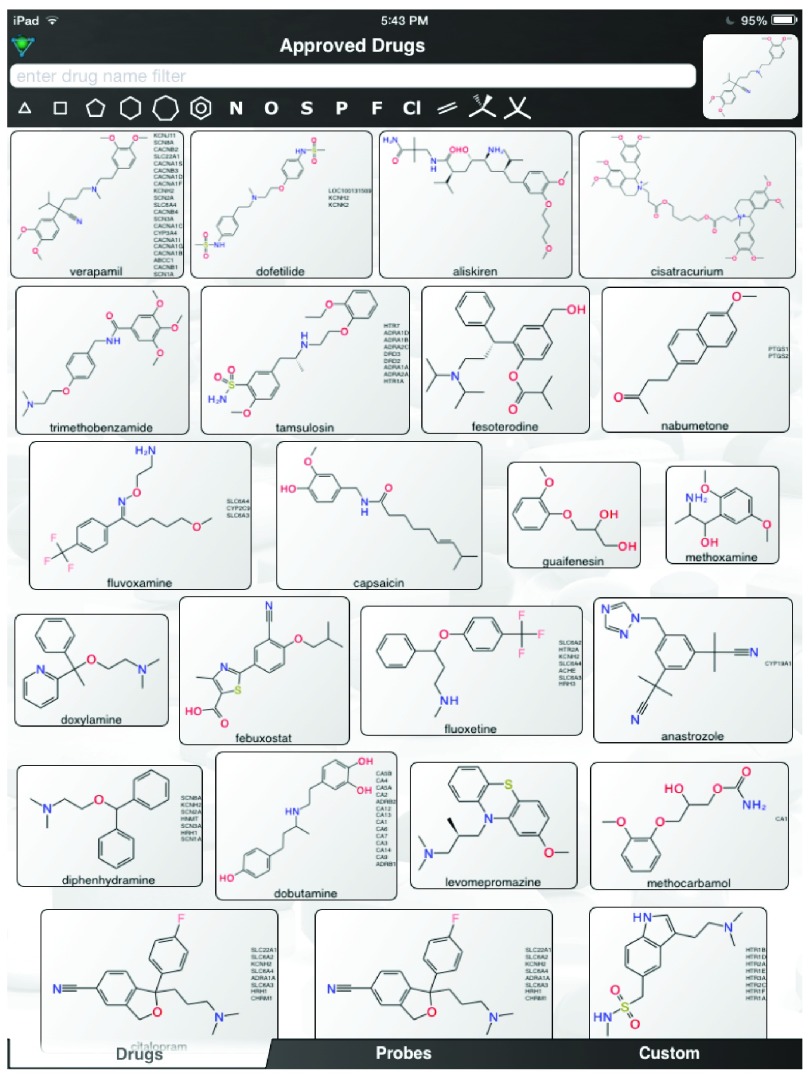
Verapamil similarity in Approved drugs mobile app
http://molmatinf.com/approveddrugs.html.